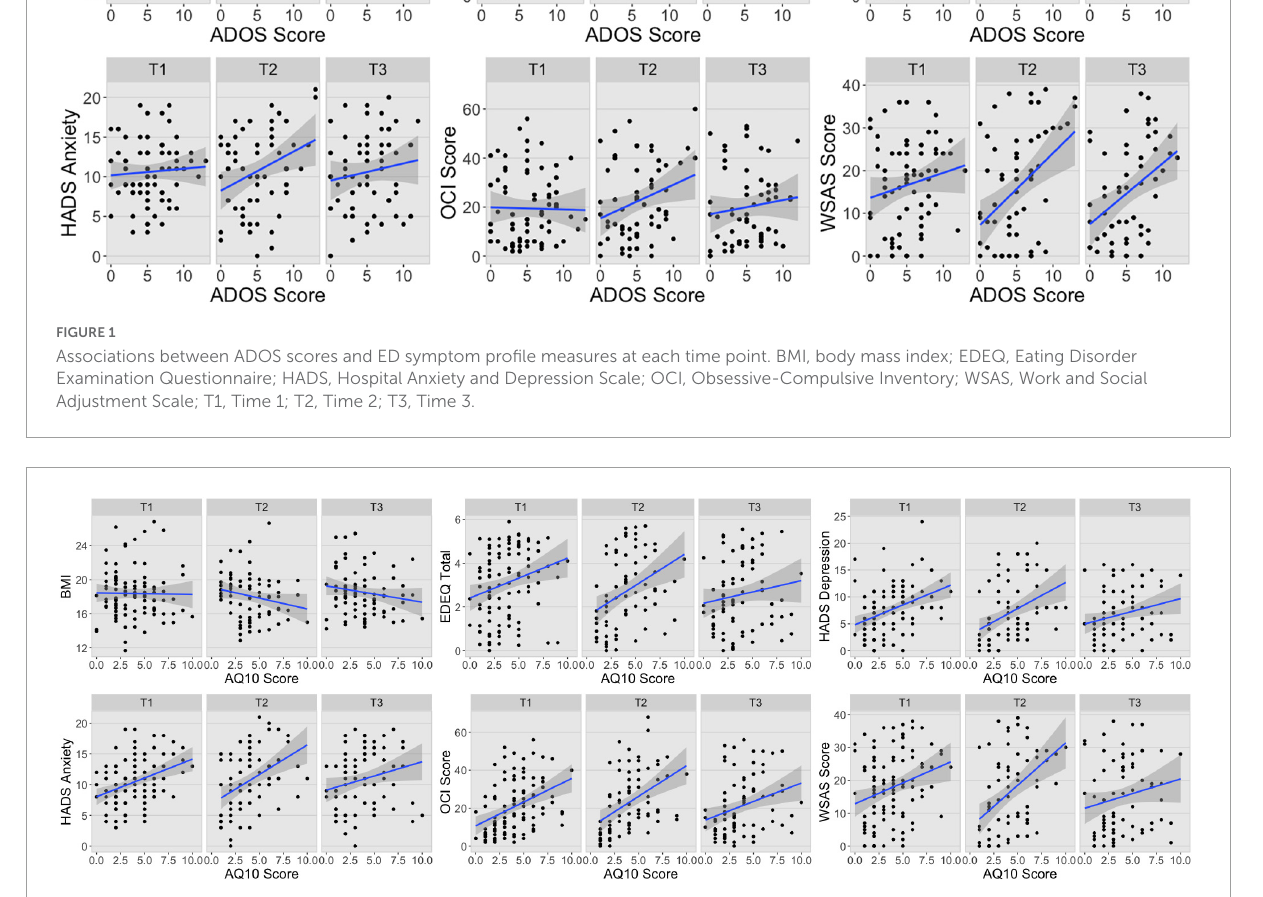
FIGURE2 Associations between AQ10 scores and ED symptom profile measures at each time point. BMI, body mass index; EDEQ, Eating Disorder Examination Questionnaire; HADS, Hospital Anxiety and Depression Scale; OCI, Obsessive-Compulsive Inventory; WSAS, Work and Social Adjustment Scale; T1, Time 1; T2, Time 2; T3, Time